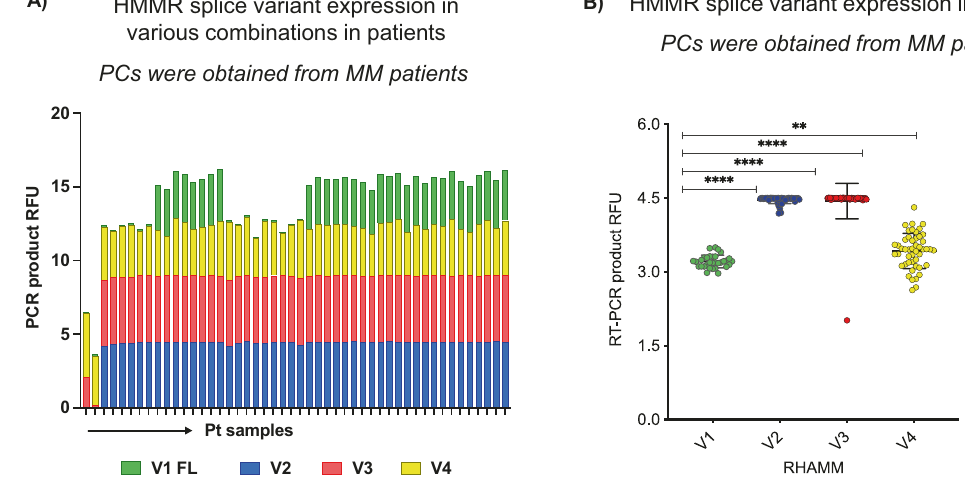
Fig. 1 HMMR splice variant transcripts are frequently expressed in MM patients. A , B HMMR transcript expression was evaluated by RT- PCR followed by DNA fragment analyses and capillary electrophoresis. On the fi gures, the y axes display relative fl uorescent units (RFU) of the PCR products. PCR product RFU = lg(RFU). RFU is a unit of measurement calculated relative to the size standards included in each reaction and compared to HMMR expression values detected in healthy donor BM PCs. In panel A , the x axes display patient samples, while in ( B ) the x